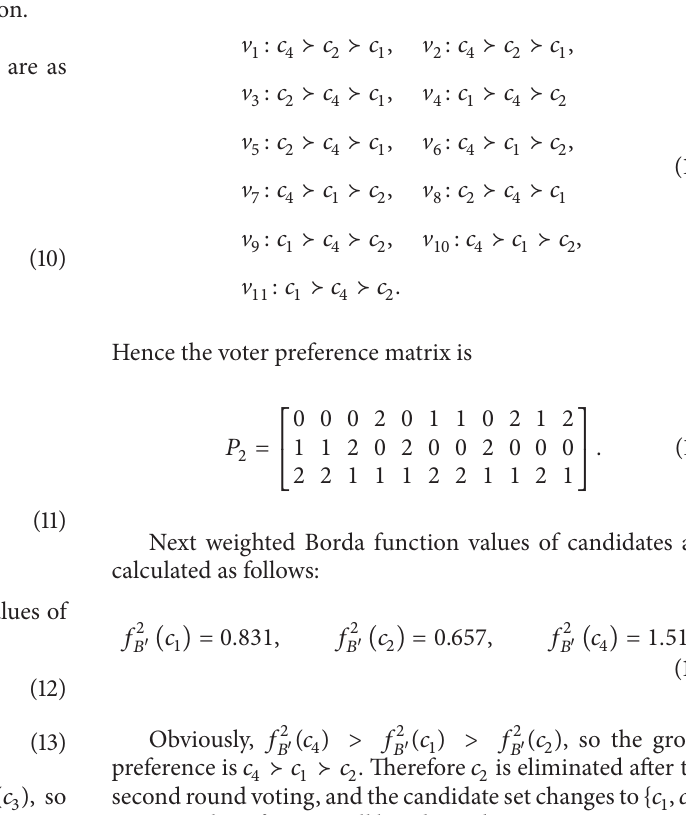
group preference, so their individual preference deviation is 0, and their weight corrections are the largest, and their weights all rise from 0.909 to 0.102. While the voter V 5 has the largest individual preference deviation, so his weight correction is the smallest and becomes negative during weight adjustment. For example, weight of voter V 5 falls from 0.909 to